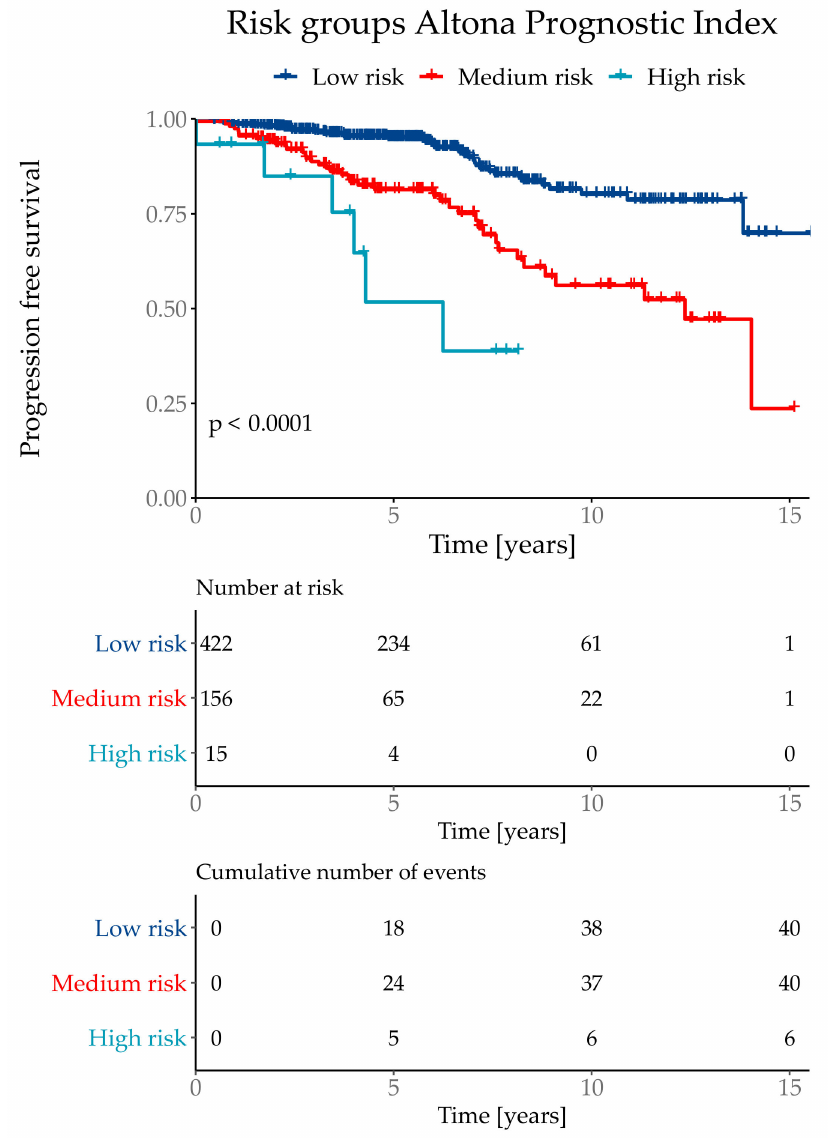
Figure 5. Kaplan–Meier curve with Log-Rank test of the risk classifications in the subtype NST (=WHO 8500/3)